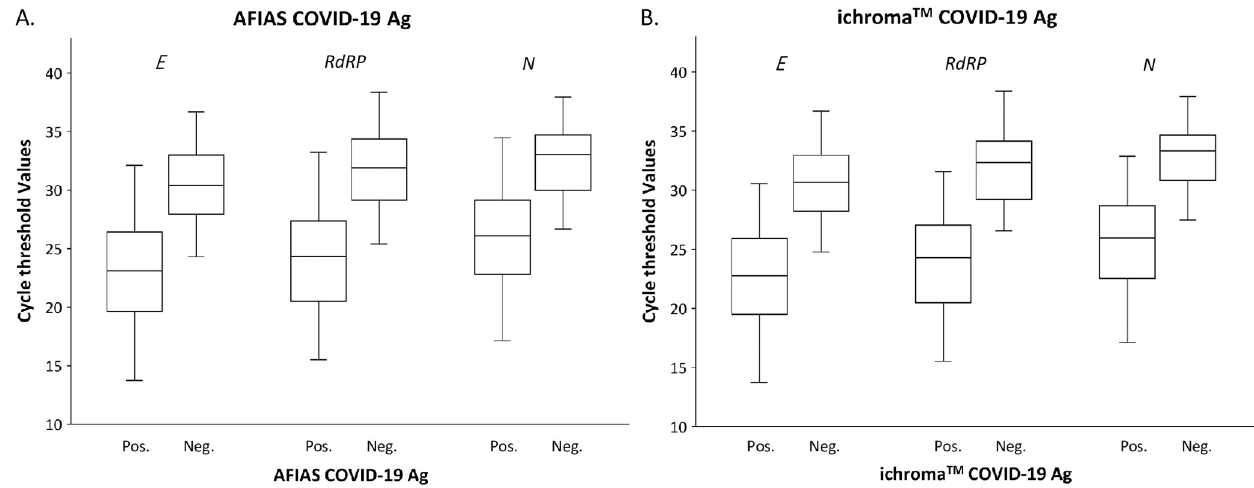
Fig 1. Cycle threshold value distribution of E , RdRP , and N genes according to the positivity of (A) the AFIAS COVID-19 Ag and (B) the ichroma TM COVID- 19 Ag assays. Abbreviations: Ag, antigen; PSO, Pos.; positive; Neg., negative. https://doi.org/10.1371/journal.pone.0249972.g001 negative specimens. Median Ct values for E , RdRP , and N genes of PCR-positive/AFIAS-posi-